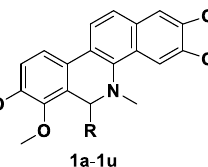
Figure 2. Reagents and reaction conditions: ( i ) TMSCN, DMAP, DCM, reflux, 14 h; ( ii ) NaBH 4, MeOH, r.t., 0.5 h; ( iii ) CH 3 CN, r.t., 3 – 8 h; ( iv ) ethyl trimethylsilylacetate, CsF, CH 3 CN, r.t., 4 – 5 h; ( v ) LiAlH 4 , THF, 5 °C, 0.5 h; ( vi ) CH 3 CN, r.t., 3 – 4 h; ( vii ) CH 3 CN, r.t., 5 – 14 h; ( viii ) CH 3 COCH 3 , 20% Na 2 CO 3 , reflux, 24 h; ( ix ) PhCOOH, piperidine, toluene, reflux, 24 h.